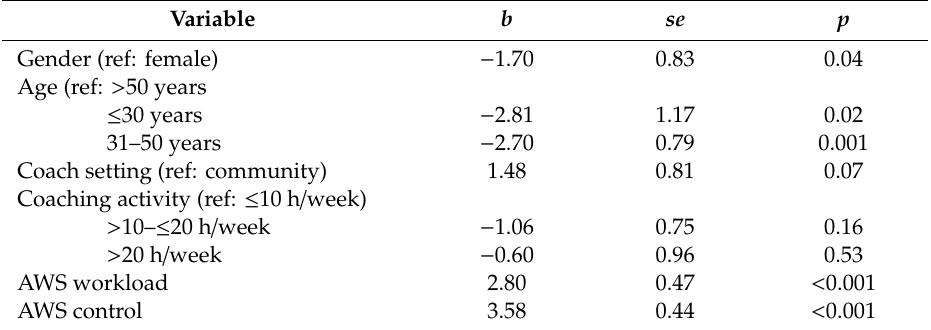
Table 3. Multivariate model predicting coach mental well-being (WEMWBS total